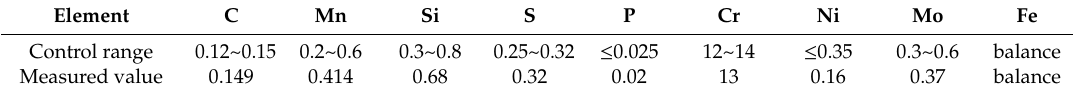
Table 1. Control range and measured value of the chemical composition of 1Cr13MoS (wt. %).